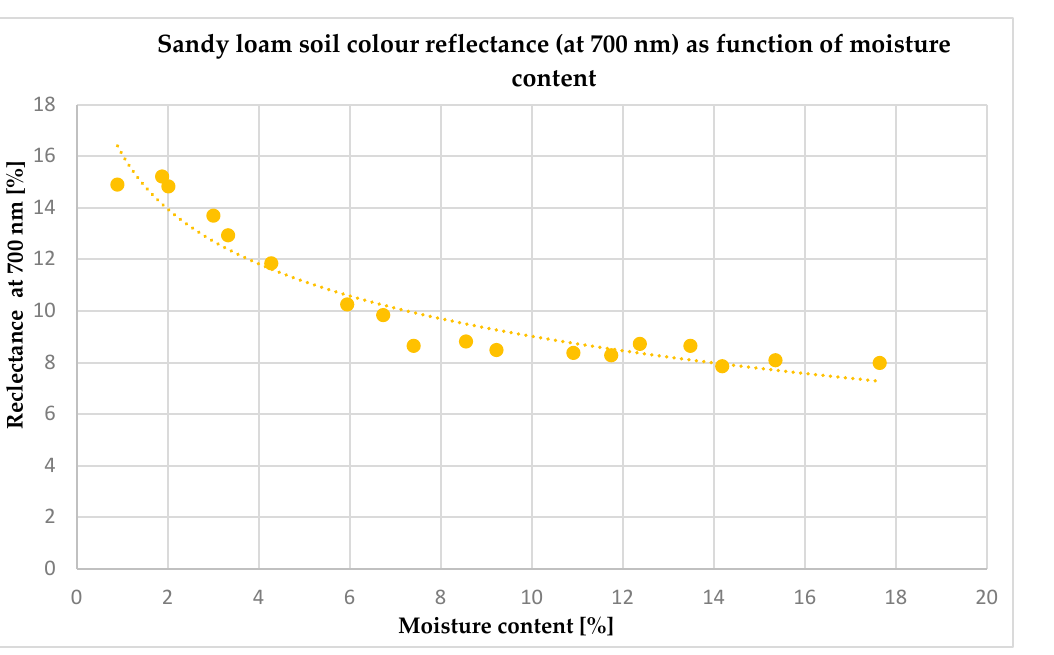
Figure 9. Colour reflectance of the tested sandy loam soil (700 nm) at different moisture contents. Analysing the curve in Figure 9 shows that the moisture values used in the measure- ment are divided into two ranges, the first section ranging from 0.9% to approximately 7.41%. Fitting a curve into the plotted points (for an accurate curve with a good regression analysis, measurement repetitions are required) will end with a useful equation for calcu- lating the moisture based on the colour reflected wavelength at 700 nm. In this range, the reflectance is changing in a clear curve path without having overlapping in the results, the case that makes calculating the moisture possible, and, thus, ending with a single moisture result in the mentioned range upon substituting a reflectance into the curve equation (equation is not given here; measurement repetitions and equation validation are required before confirming an equation).